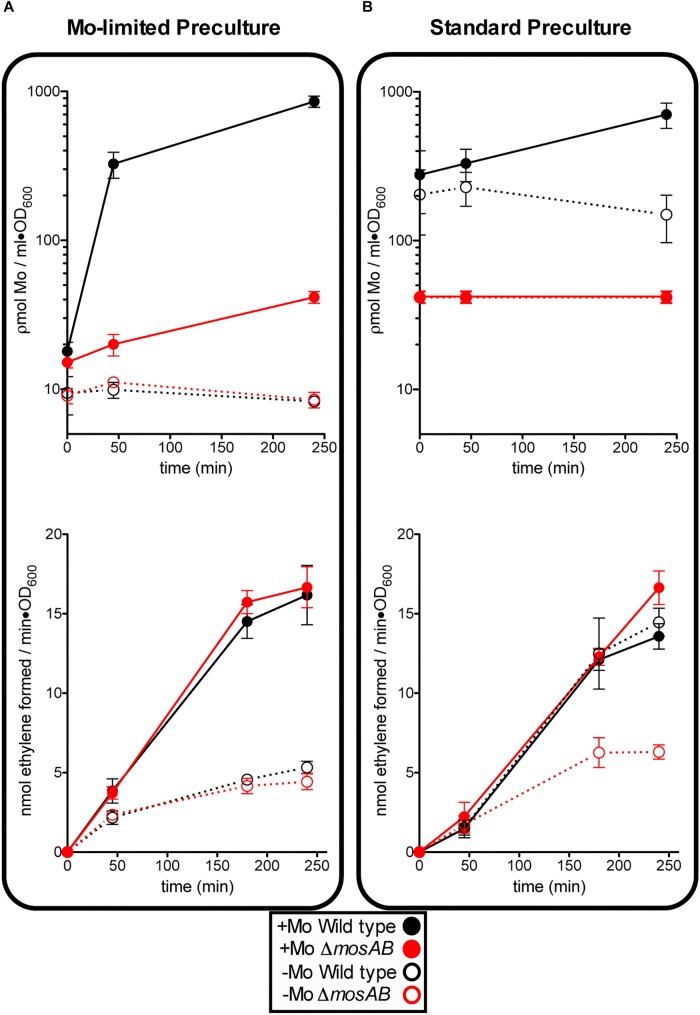
Effect of MoSto on molybdenum accumulation and in vivo nitrogenase activity in A. vinelandii. Mo-Starved (A) or Standard grown (B) cells of A. vinelandii DJ (wild type; black symbols) or UW394 (ΔmosAB, red symbols) were inoculated into Burk’s modified N-limited medium containing (close symbols) or lacking (open symbols) 1 μM molybdate. All media contained 1 μM vanadate. Data represent mean ± standard deviation of three independent experiments.